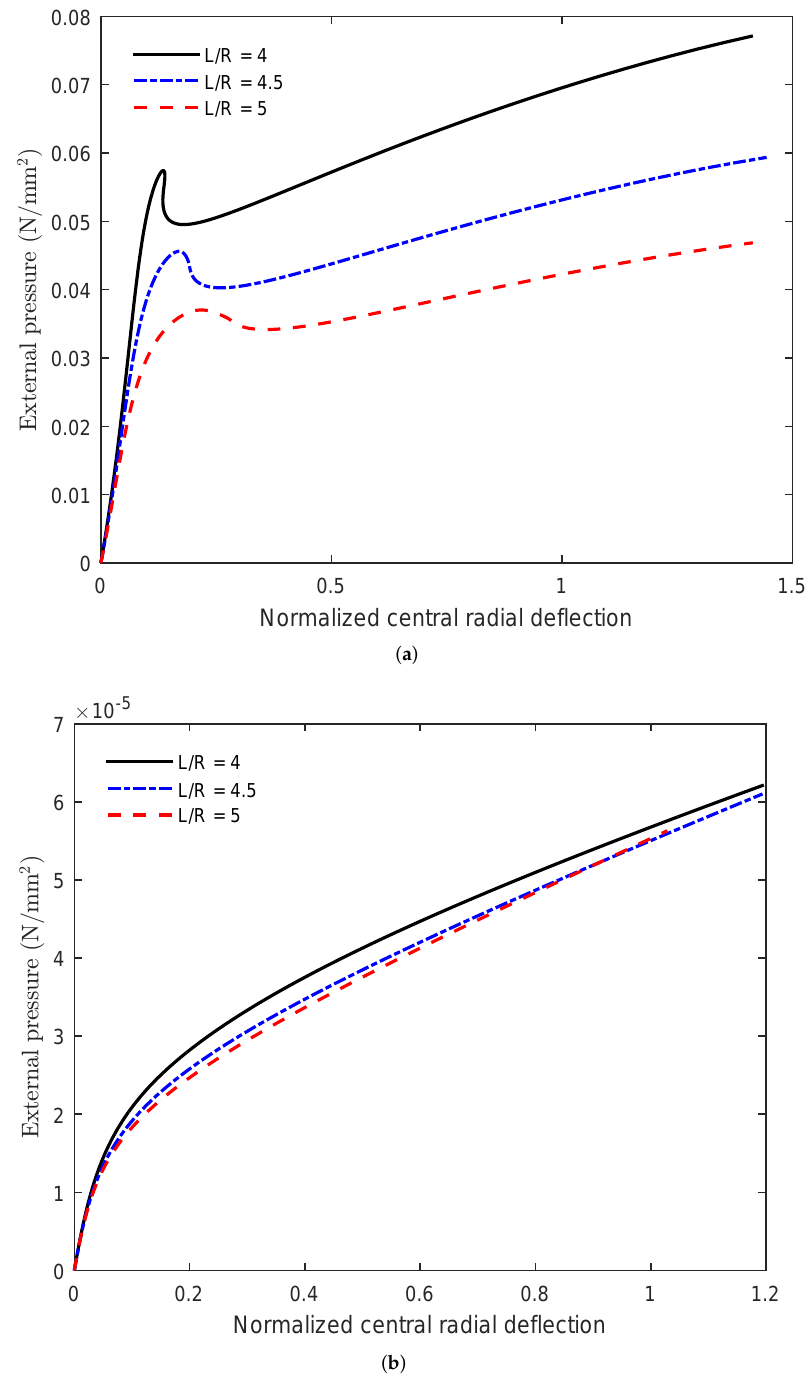
Figure 19. Normalized central radial deflections ˆ w of clamped FG-CNTRC cylinder shells/membranes = 0.11, UD distribution, various L / R . ( a ) Cylinder shells, under external pressure with V ∗ CNT R / h = 100, ( b ) cylinder membranes, R / h =